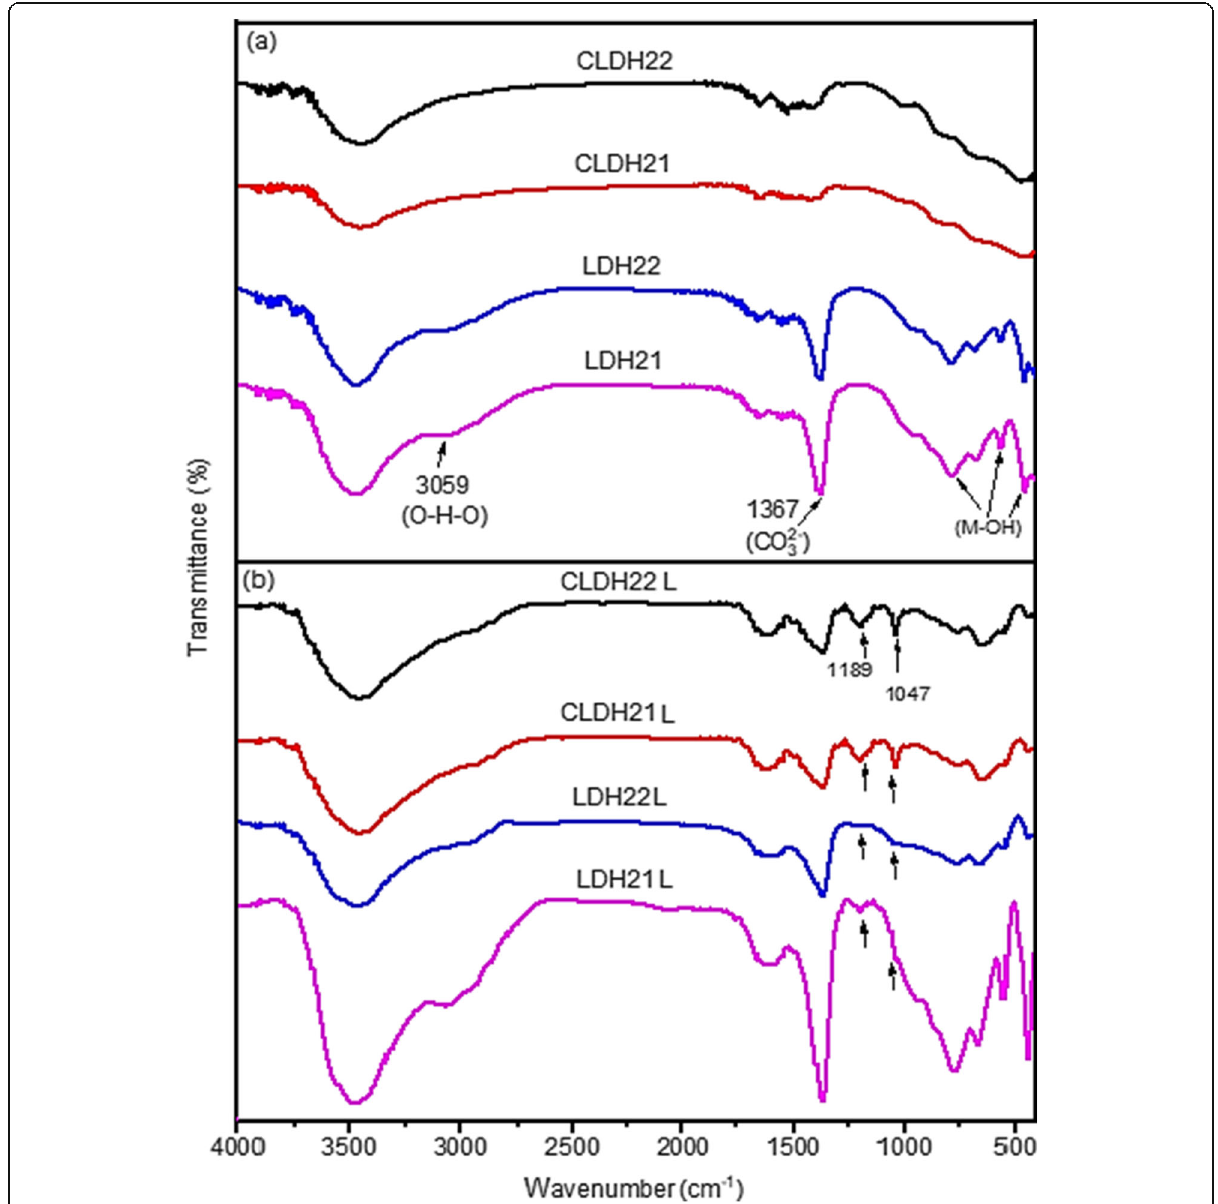
Fig. 1 FTIR spectra of LDHs, CLDHs ( a ) and loaded sorbents with IDB dye ( b